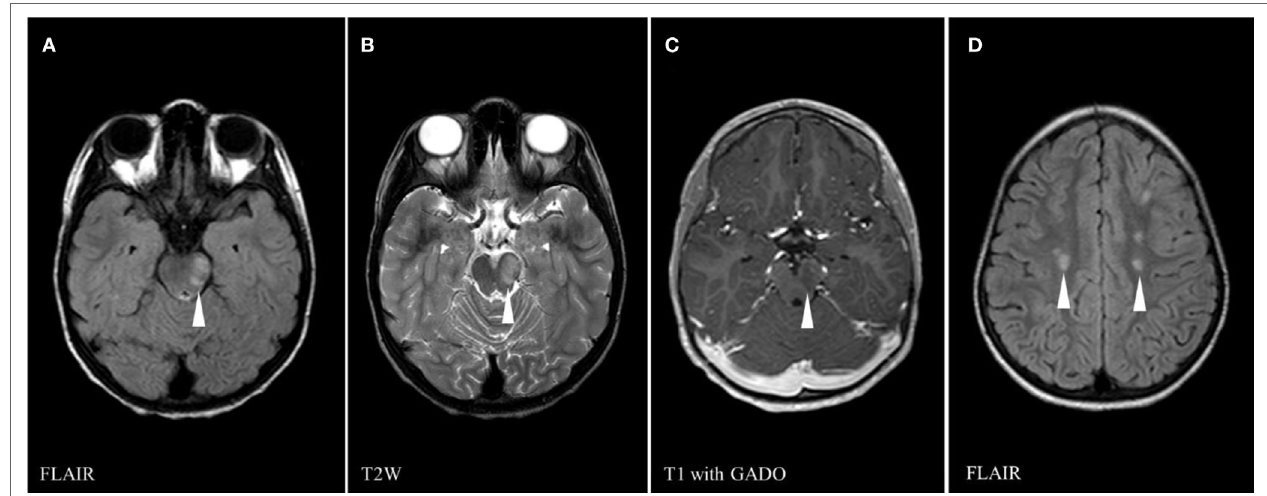
FIguRe 1 | Brain magnetic resonance imaging on first presentation (day 5) showing multiple areas of abnormal signals (white arrowheads): left midbrain high signal on FLAIR sequence (a) , left midbrain hypersignal on T2 weighed (T2W) sequence (B) , central gadolinium enhancement of left midbrain lesion on T1 sequence (C) , and scattered supratentorial white matter foci of high FLAIR signal (D) .